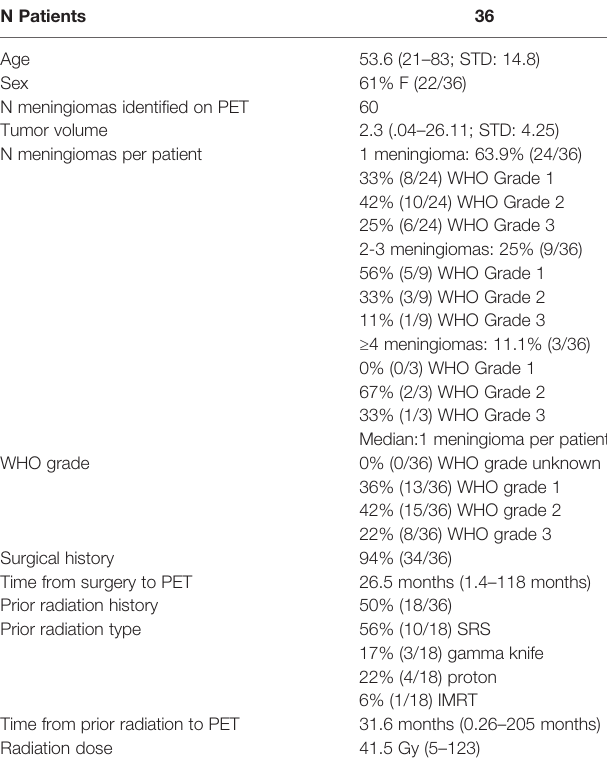
TABLE 1 | Clinical characteristics of the patient population.